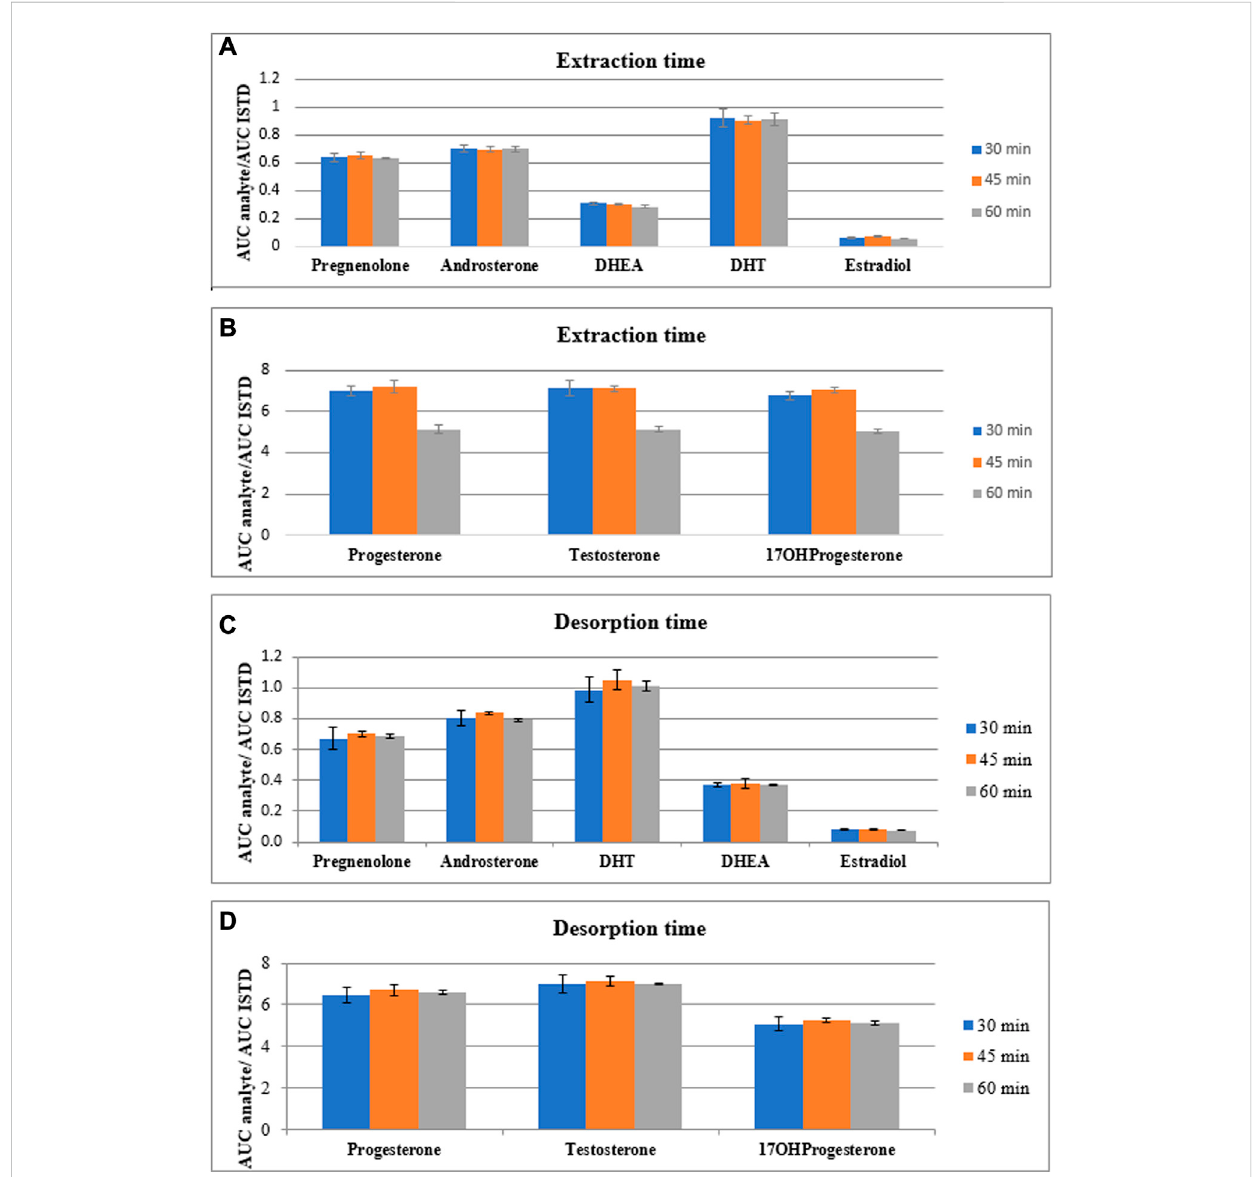
FIGURE 4 The comparison of peak area of steroid hormones normalized by peak area of internal standard for eight steroid hormones extracted (A, B) and desorbed (C, D) during various time points (30, 45 and 60